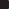
Effects of DM on HFD-induced obesity in C57BL/6 mice. DM (250 or 500 mg/kg) or orlistat (50 mg/kg) were administered by oral gavage for 8 weeks while the mice were fed the HFD. (A) Experimental outline. (B) Body weight was measured 3 times per week. The group that received HFD alone () showed steady body weight gain, while the DM-( or ) and orlistat-treated () groups showed significantly attenuated body weight gain. (C) Adipose tissue weight of subcutaneous, epididymal, and mesentery fat. (D) Amount of leptin in plasma measured by ELISA. (E) Liver weight. (F) Plasma levels of GOT and GPT measured using a chemical analyzer. (G) H&E-stained images of liver and subcutaneous adipose tissue samples from the normal diet (control), vehicle-treated, DM-treated, and orlistat-treated groups. The results are expressed as the mean ± SD for each group (n = 8). #p < 0.05 compared with the control group; ∗p < 0.05 compared with the HFD-treated vehicle group.